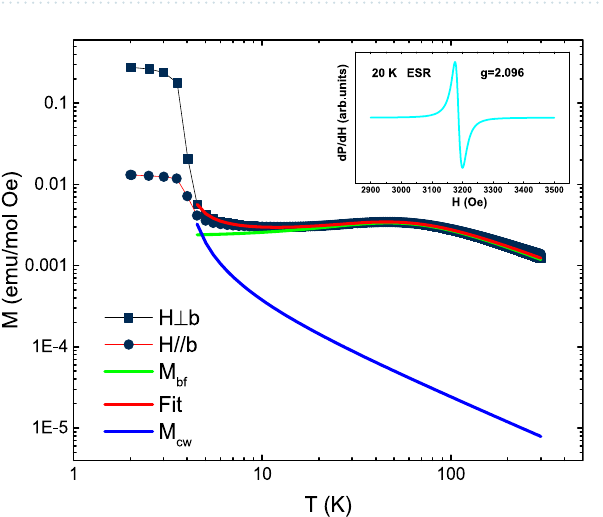
Figure 1. Top view ( a ) and side view ( b ) of the perovskite-like structure of [CH 3 NH 3 ][Cu(HCOO) 3 ]. CH 3 NH 3+ occupied the pseudo cubic cavity formed by Cu 2+ and CHOO − . Cu 2+ ions in the endpoints of chains constitute a 2D square lattice. The crystal structure diagram was drew by Diamond (version 4.6.5). http:// www. cryst alimp act. com/ diamo nd 27 .